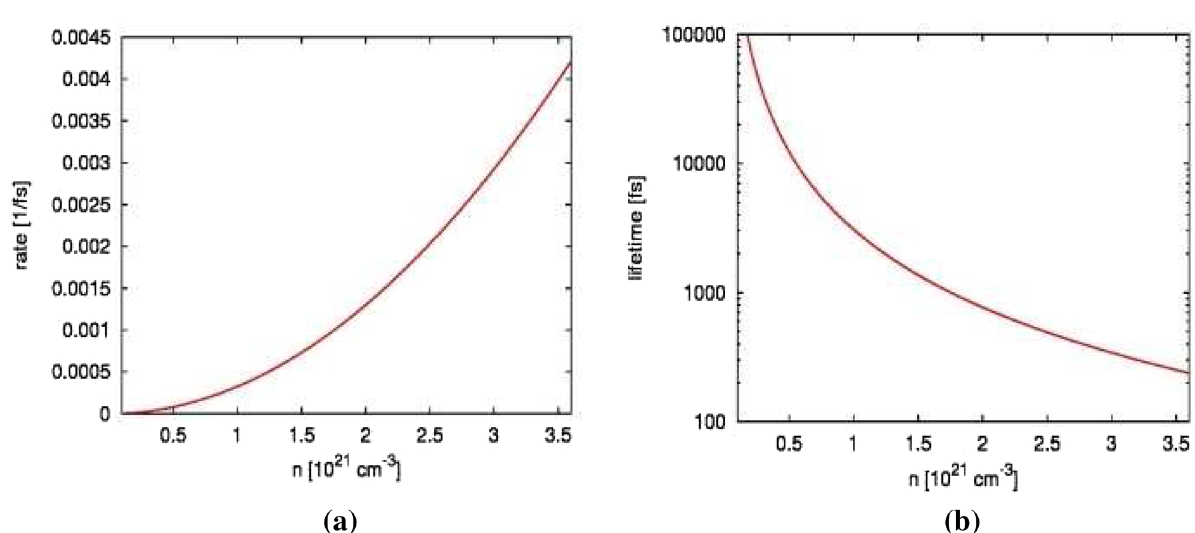
2 , and ( b ) the respective lifetime, τ AR = 1 /( C AR · n